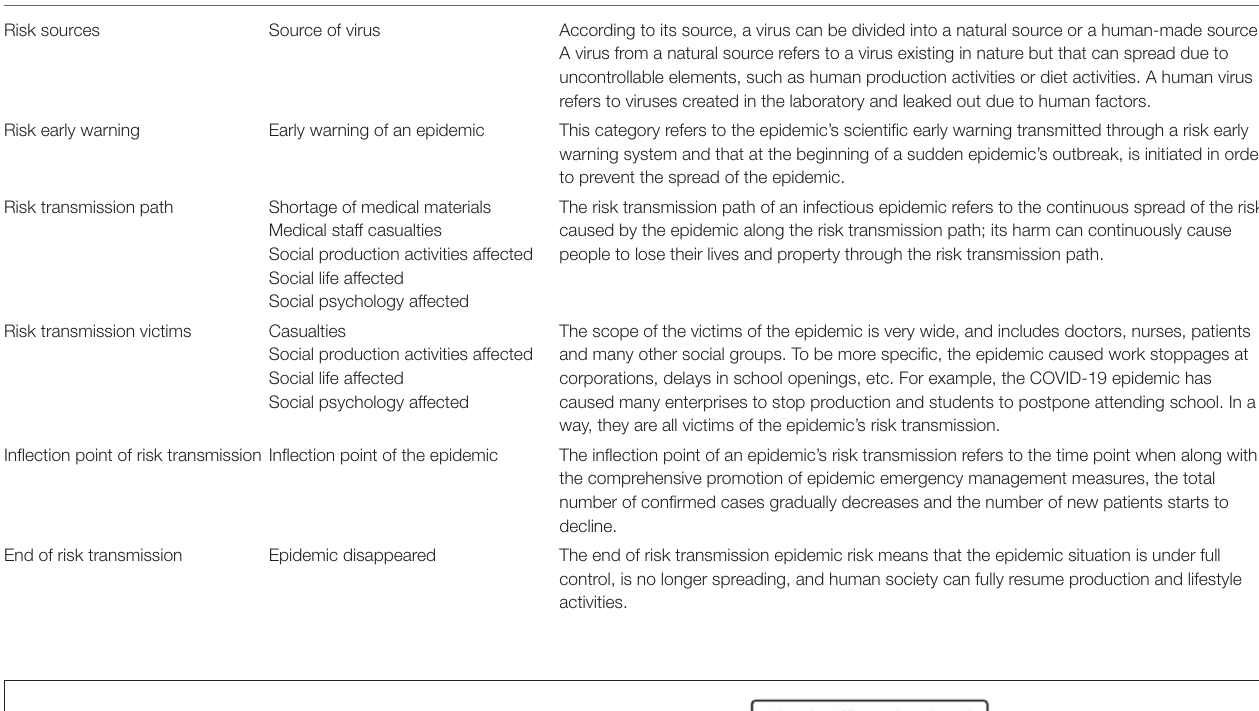
TABLE 2 | Axial coding.